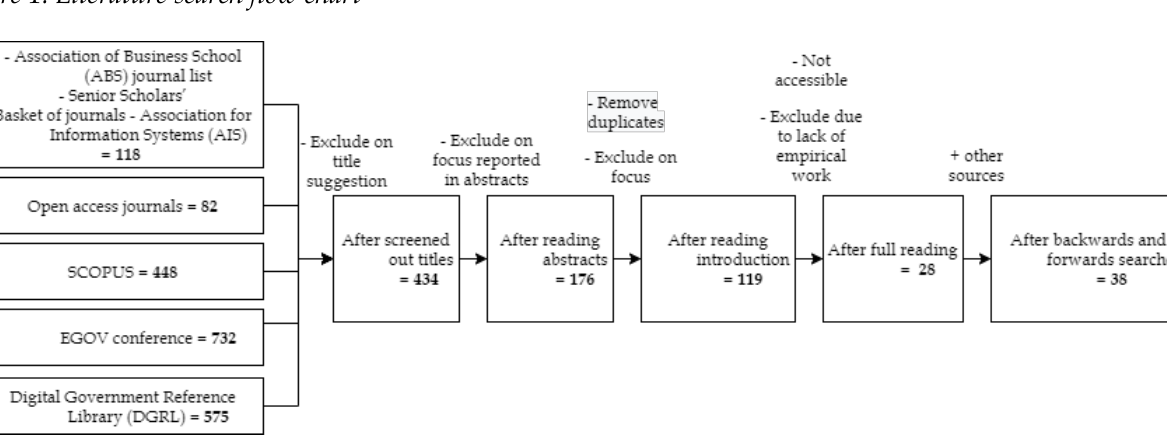
Figure 1: Literature search flow chart